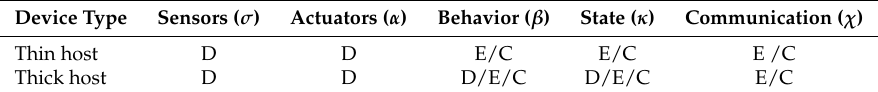
Table 1. Available choices for pulverized component deployment for different device types in the extended DingNet simulator. D indicates that the component can be deployed on the local device directly, E that it can get deployed on edge, and C on cloud. The simulator supports only configurations where behavior and state are located onto the same type of host (e.g., edge-edge). The devices can